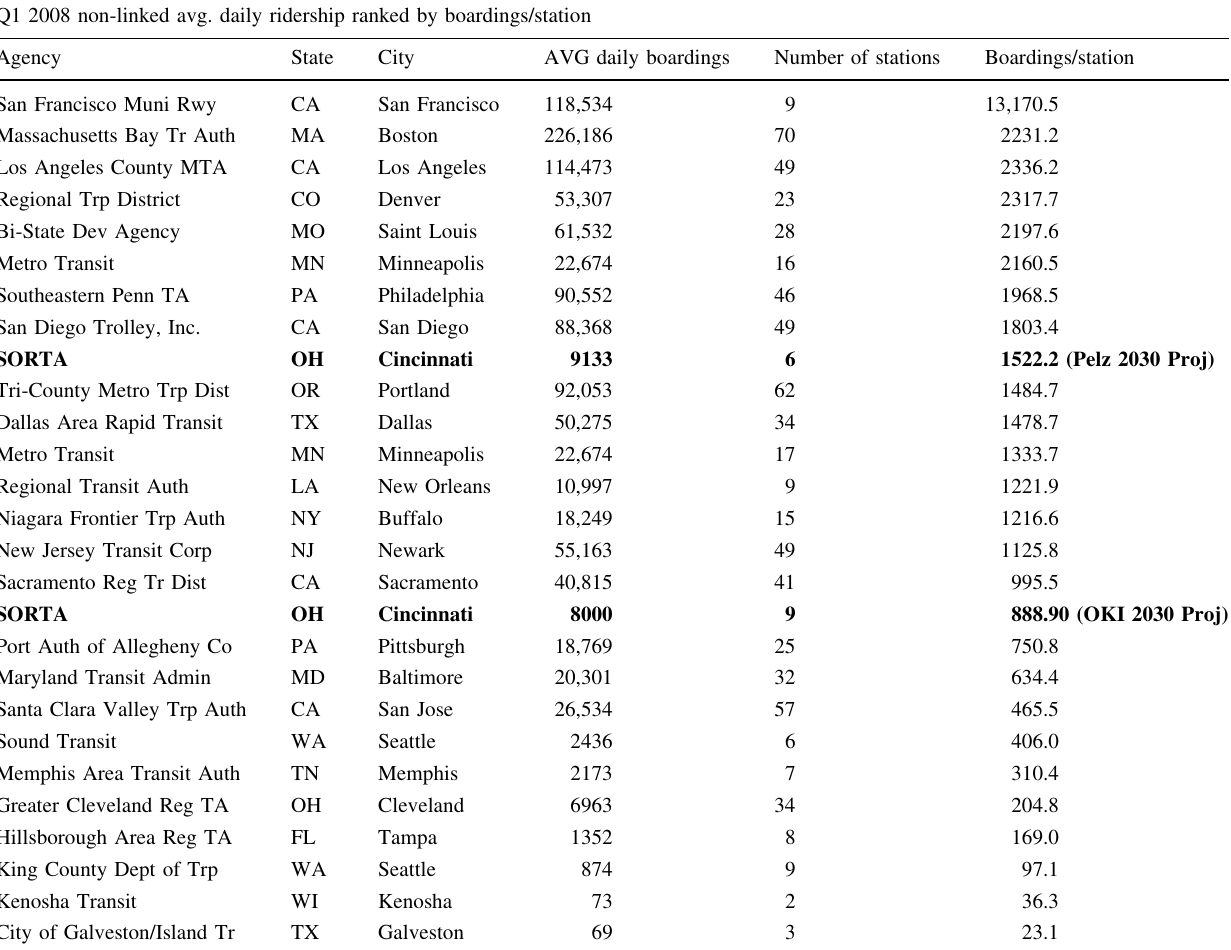
Table 4 1st Quarter 2008 Light rail agency ridership, boardings per station [12], [15, 16] Q1 2008 non-linked avg. daily ridership ranked by